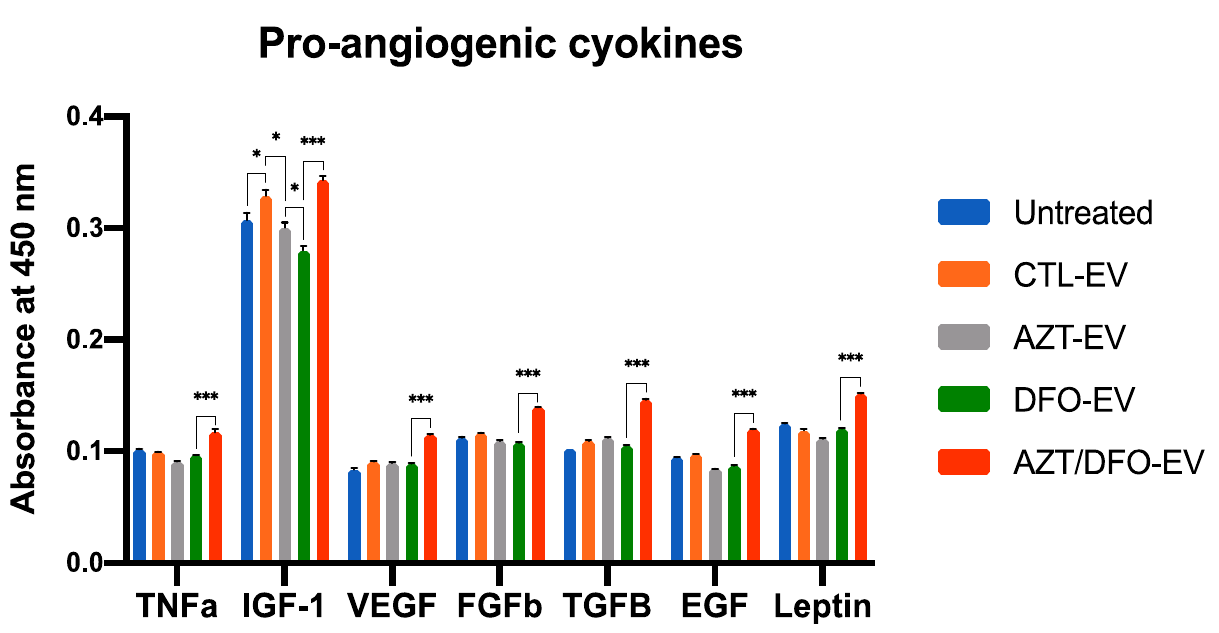
Figure 8. Angiogenic cytokines released from EV-treated HUVECs. The pro-angiogenic cytokine release pro fi le of HUVECs treated with hBMSC-EVs for 3 days. Data are expressed as mean ± SD ( n = 3). * p ≤ 0.05 and *** p ≤ 0.001.